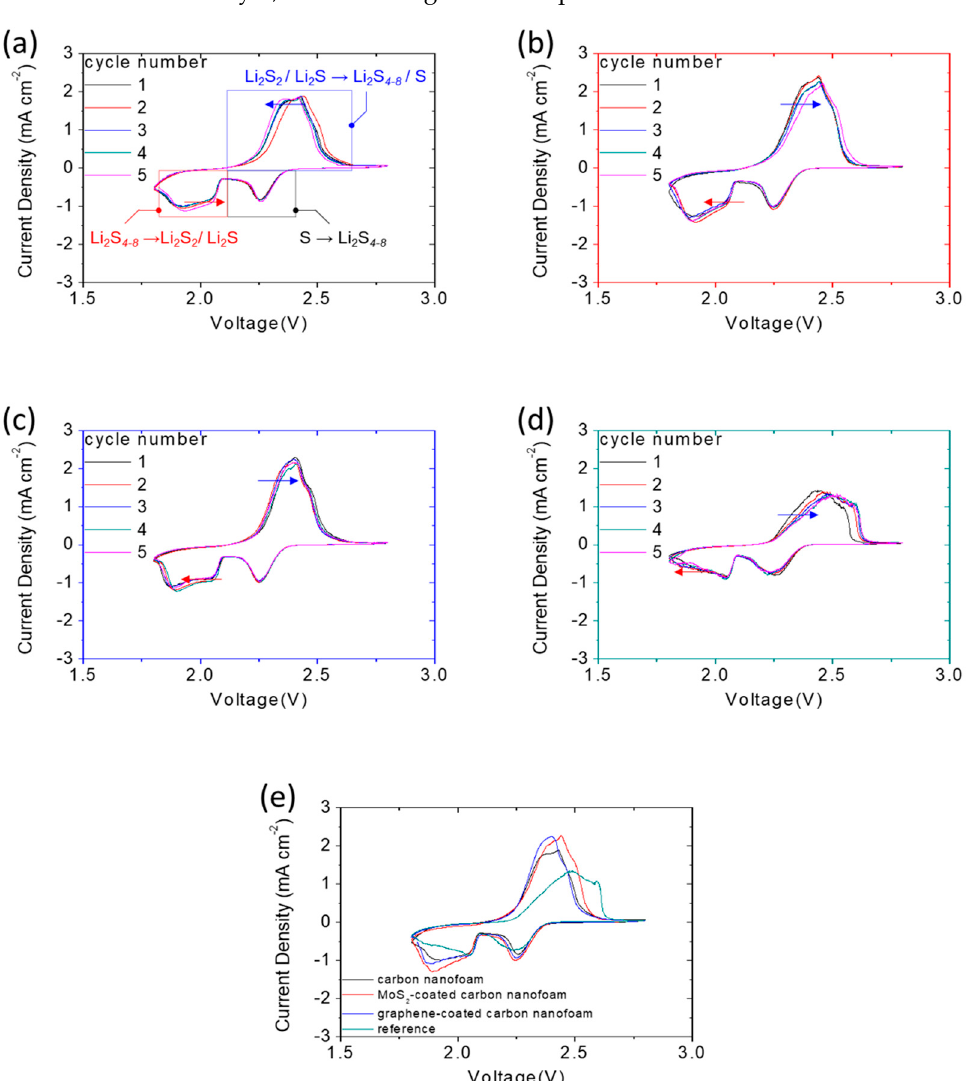
Figure 6. Electrochemical analysis: cyclic voltammetry (CV) analysis of the sulfur cathodes with ( a ) the carbon-nanofoam interlayer, ( b ) the MoS 2 -coated carbon-nanofoam interlayer, ( c ) the graphene-coated carbon-nanofoam interlayer, ( d ) the reference cathode, and ( e ) various carbon-nanofoam interlayers.